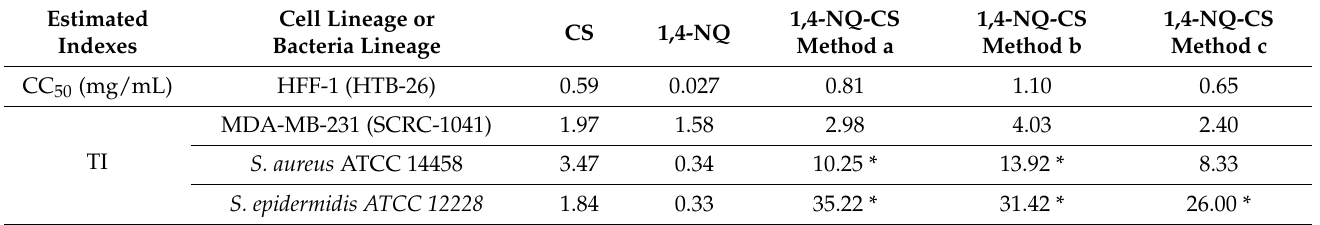
Table 4. Cytotoxic concentrations (CC 50 ) of 1,4-NQ-CS against a human healthy fibroblast lineage and therapeutic index (TI)